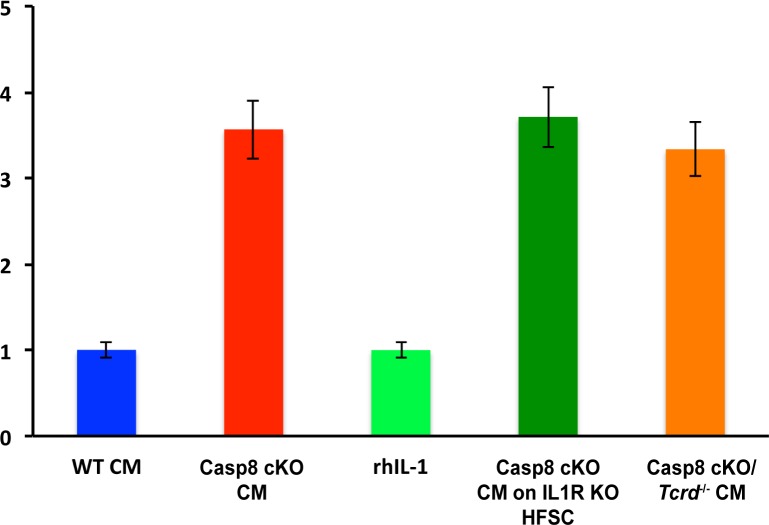
In vitro migration of HFSCs.WT or IL-1RKO HFSCs were plated on the top of a transwell chamber with conditioned media from WT, caspase-8 conditional KO (Casp8 cKO), caspase-8 conditional KO/gdTCRKO (Casp8 cKO/Tcrd-/-) or with recombinant human IL-1 (rhIL-1) in the lower chamber. HFSC migration to the lower side of the membrane was quantified after 24 hr. Results are presented as fold change relative to WT migration level, which was set at 1.